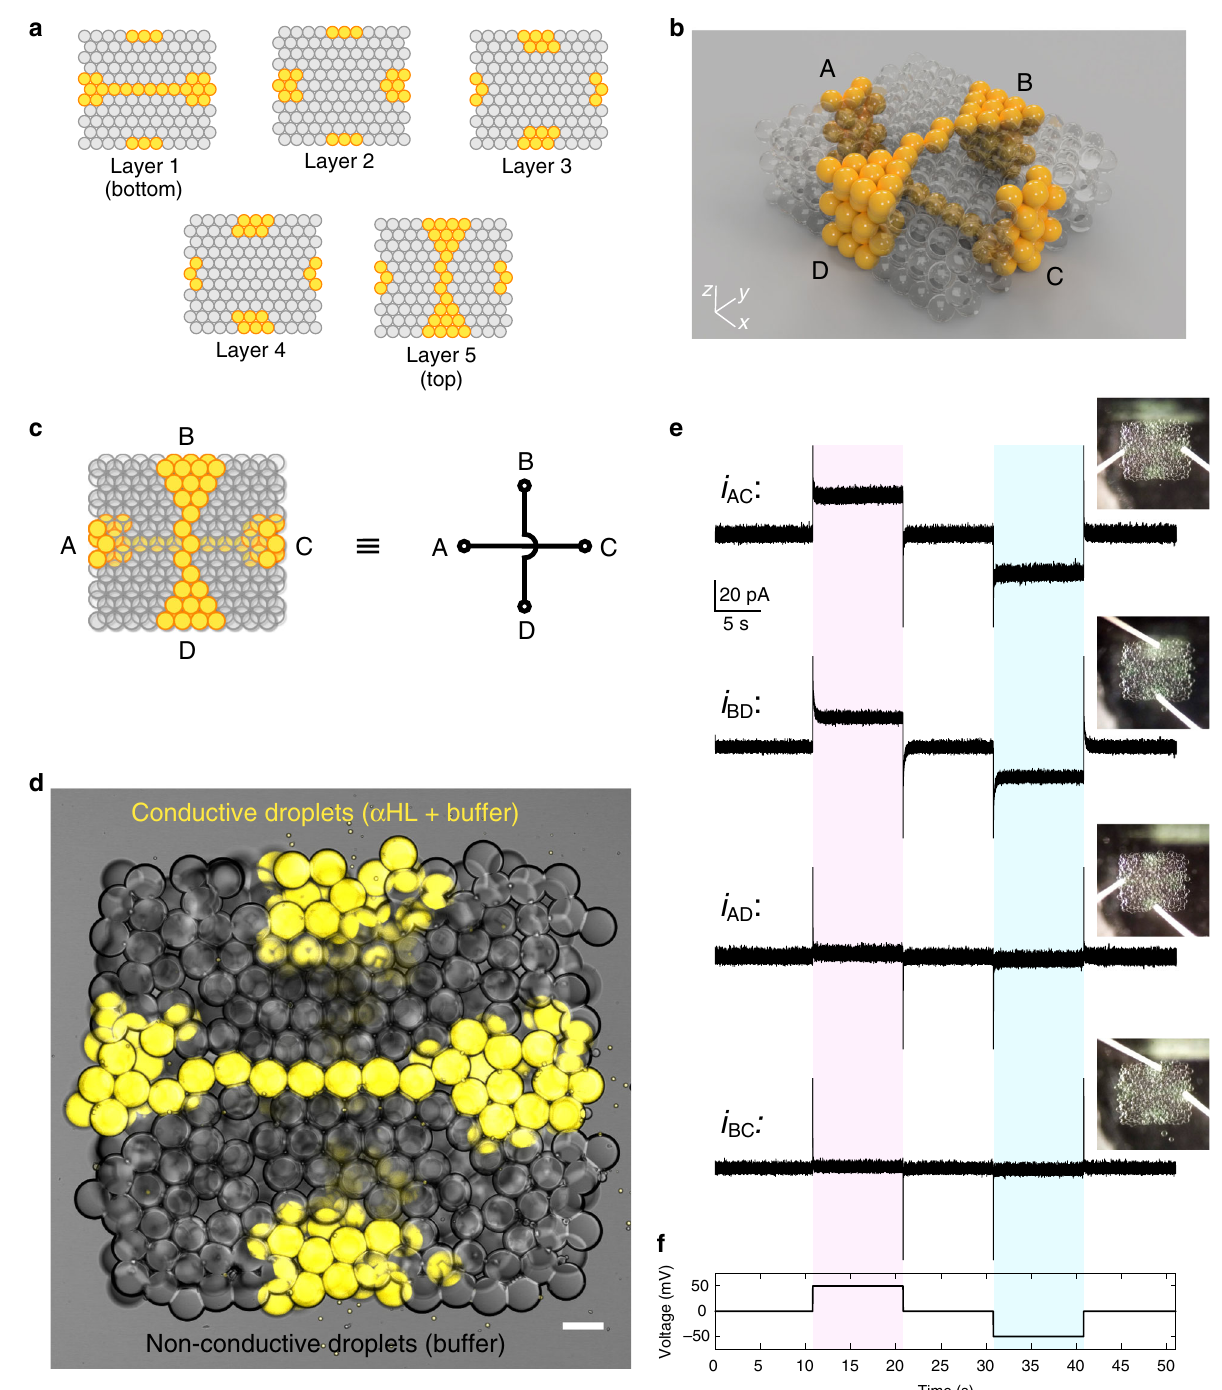
Fig. 6 Synthetic tissues with features patterned at single-droplet resolution. a Maps of the fi rst (bottom), second, third, fourth and fi fth (top) layers of a 3D-printed synthetic tissue in which two conductive, single-droplet-wide pathways containing α HL (in yellow) are patterned in 3D within a network of non- conductive droplets (in grey). b A computer model displaying the 3D architecture of the synthetic tissue. The two single-droplet-wide pathways span the synthetic tissue, one horizontally at the bottom (connecting A to C), and one vertically at the top (connecting B to D) of the network. c Simpli fi ed diagram of the synthetic tissue, and equivalent circuit model. d Bright- fi eld and fl uorescent microscopy overlay of the synthetic tissue. Droplets in the single- droplet-wide conductive pathways contained α -hemolysin (60 µ g mL − 1 ), 25 mM Tris-HCl (pH 7.6), 1 M NaCl and 10 µ M Atto488 fl uorophore (false coloured in yellow). Scale bar = 100 µ m. e Electrical recordings of the ionic currents fl owing through the two single-droplet-wide conductive pathways connecting A to C ( i AC ) and B to D ( i BD ) upon application of the voltage protocol shown in f . When a potential of ± 50 mV was applied, changes in ionic currents of + 25.6 ± 1.4 pA (at positive potential) and − 25.6 ± 1.5 pA (at negative potential) were observed for i AC , and of + 19.4 ± 1.2 pA (at positive potential) and − 19.8 ± 1.3 pA (at negative potential) for i BD . Conversely, we recorded non-signi fi cant changes in ionic current for the same applied potentials between A and D ( i AD ) or B and C ( i BC ). i AD : + 1.8 ± 1.3 pA and − 1.8 ± 1.4 pA (at positive and negative potentials respectively); i BC : + 0.9 ± 1.1 pA and − 0.9 ± 1.1 pA (at positive and negative potentials,